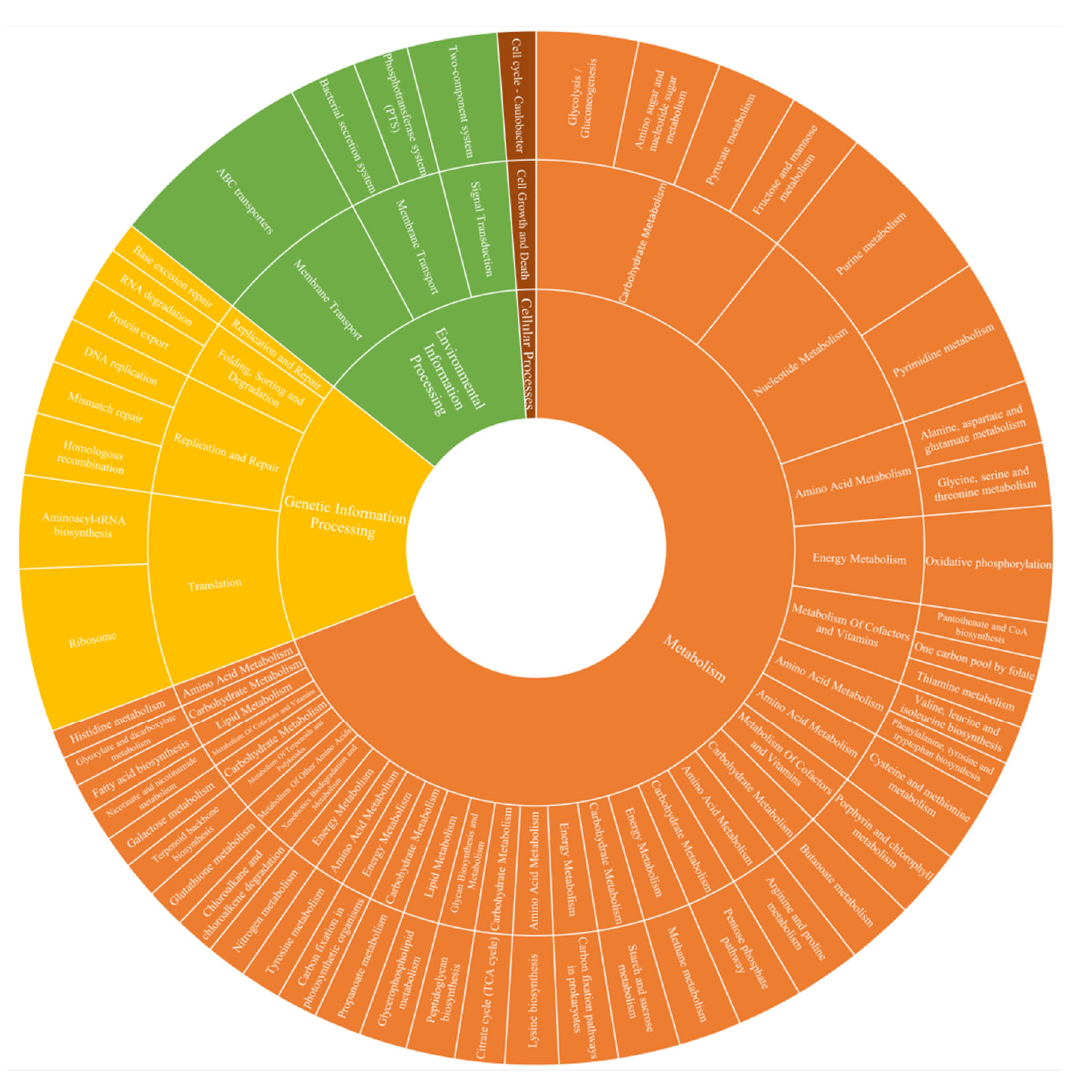
Figure 7. Annotation of KEGG functions of bacterial OTUs in fermented grain samples. Note: The innermost ring, Pathway level1; intermediate ring, Pathway level2; outermost ring, Pathway level3; sector area, OTU abundance size.